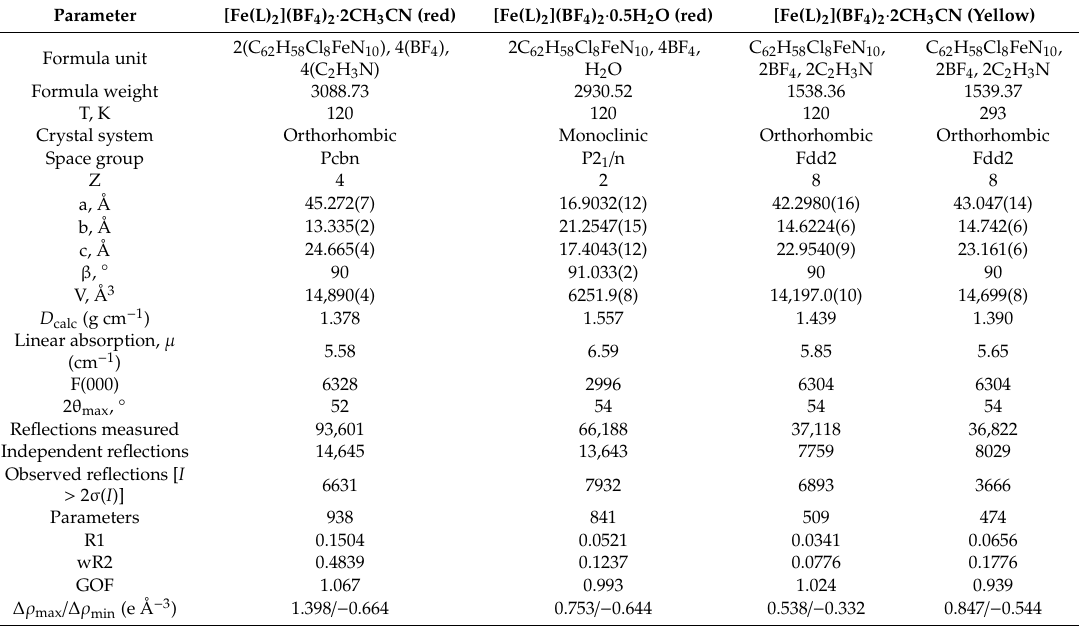
Crystal data and structure refinement parameters for [Fe( L ) 2 ](BF 4 ) 2 · 2CH 3 CN